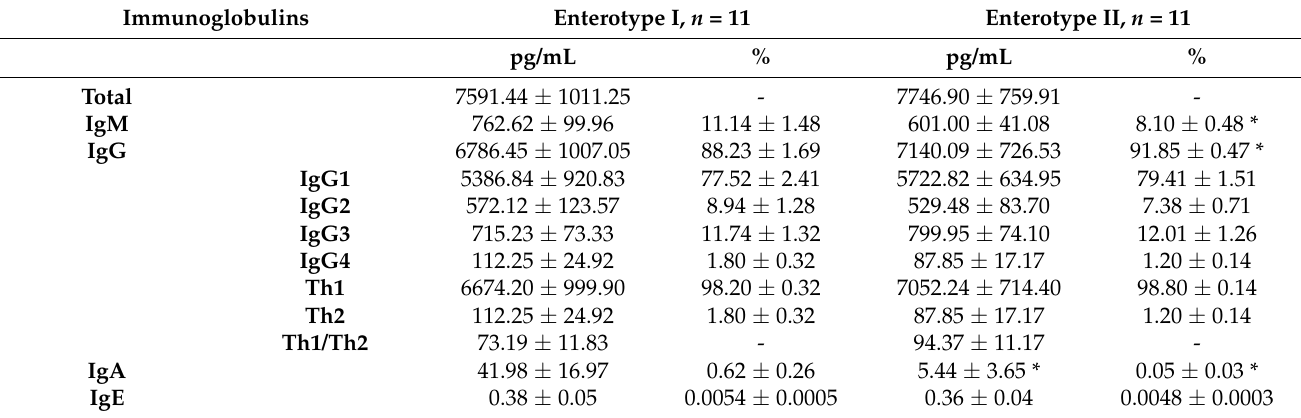
Table 5. Immunoglobulin composition of umbilical cord plasma from each maternal enterotype.